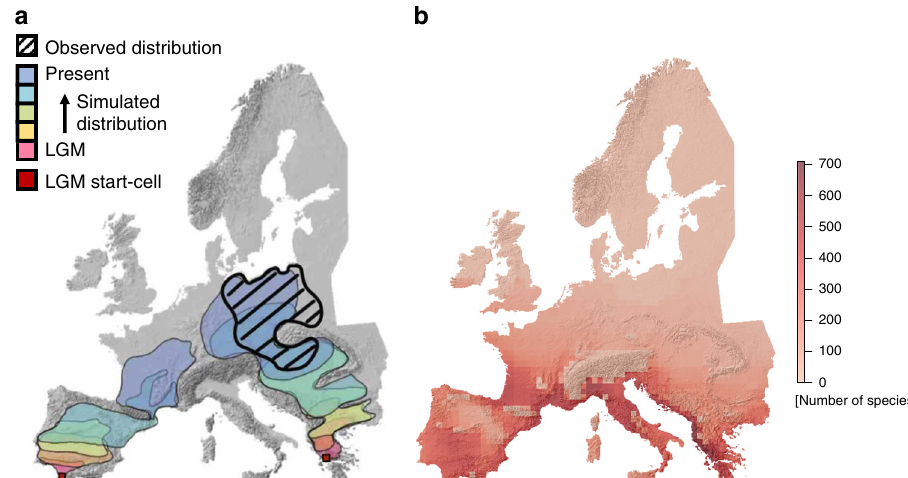
Fig. 4 Dynamic range expansion since LGM and angiosperm diversity during LGM. a Illustration of dynamic range expansion from two possible start- cells during the last glacial maximum (LGM) using KISSMig 36 that had suitable LGM climate for a given species. Dynamic simulations from all cells that had suitable climates during LGM were used for each species to identify LGM refugial cells from which current distribution ranges likely were colonized. Colonization from SW Europe does not represent a likely colonization of the current habitat (and is rejected as refugial cell) while colonization from SE Europe does. b Angiosperm richness of identi fi ed LGM refugia across all species using dynamic KISSMig simulations. The underlying hillshade maps of Europe are based on the digital elevation model of the European Environment Agency 81